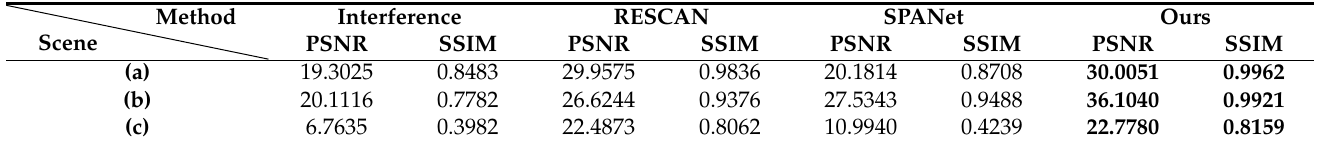
Table 2. Comparisons of SSIM and PSNR for simulation